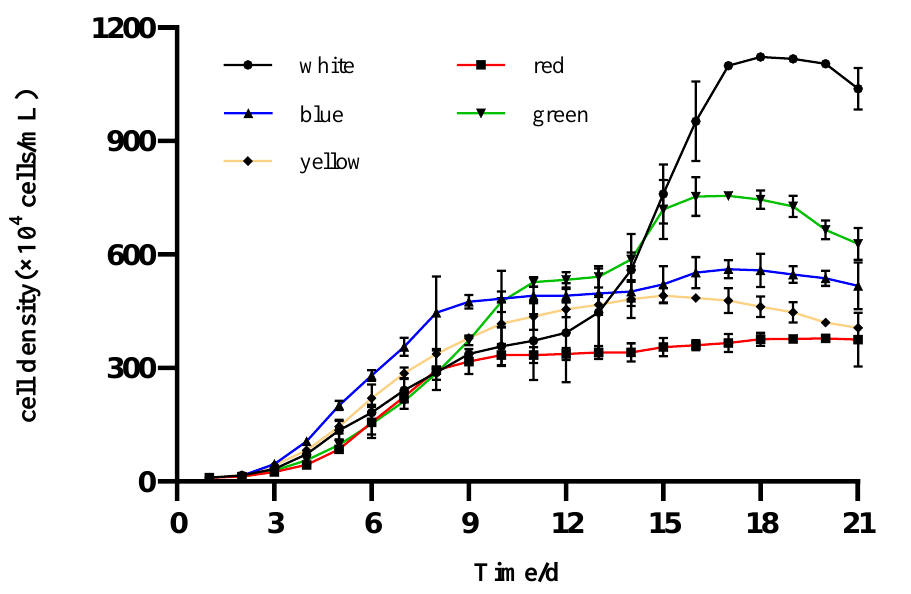
Figure 1. Daily mean growth of I. zhangjiangensis cultured under different colored LEDs (n = 3, p < 0.05 t -test).